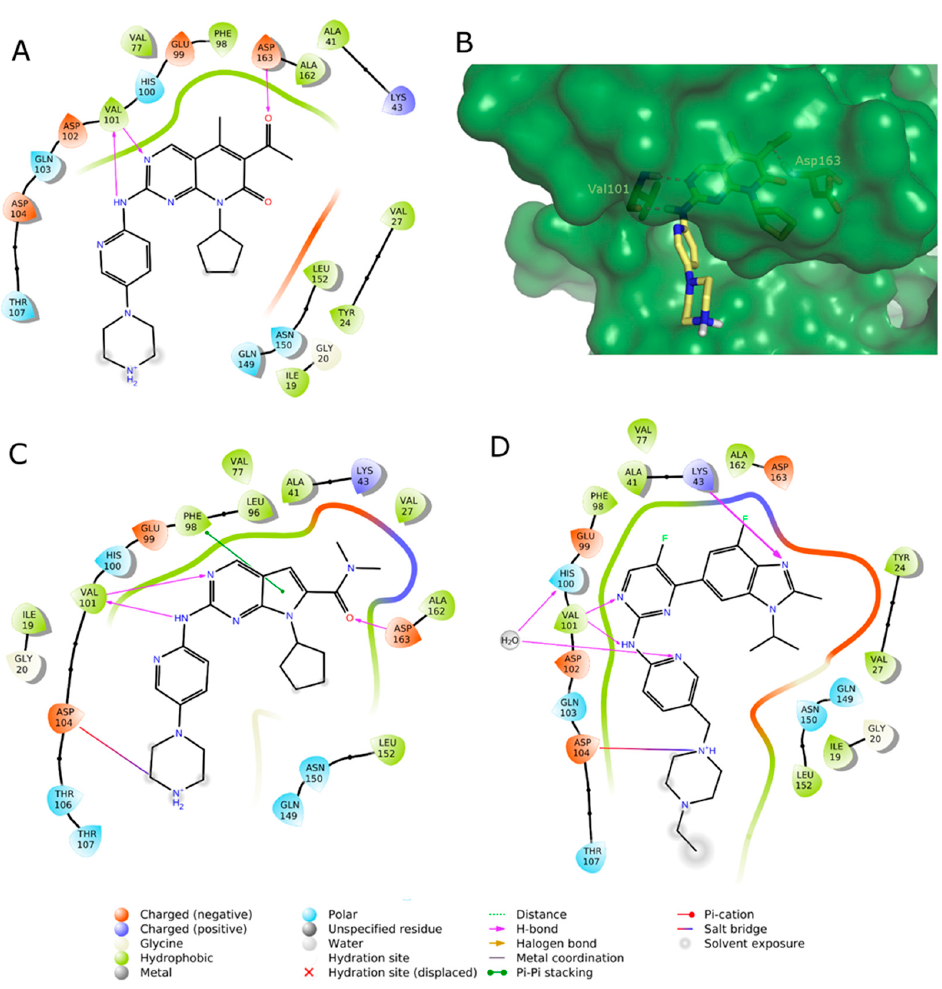
Figure 4. ( A , C , D ): 2D interaction diagram of the three approved CDK4/6 selective inhibitors as observed in their X-ray complexes into CDK6: ( A ) palbociclib (PDB ID: 5L2I); ( C ) ribociclib (PDB ID: 5L2T); ( D ) abemaciclib (PDB ID: 5L2S). ( B ): 3D representation of the X-ray binding geometry of palbociclib (stick, yellow C atoms) into the CDK6 binding site (dark green solid surface). Protein residues involved in key H-bond interactions are represented as stick; H-bonds are depicted as magenta dashed lines.